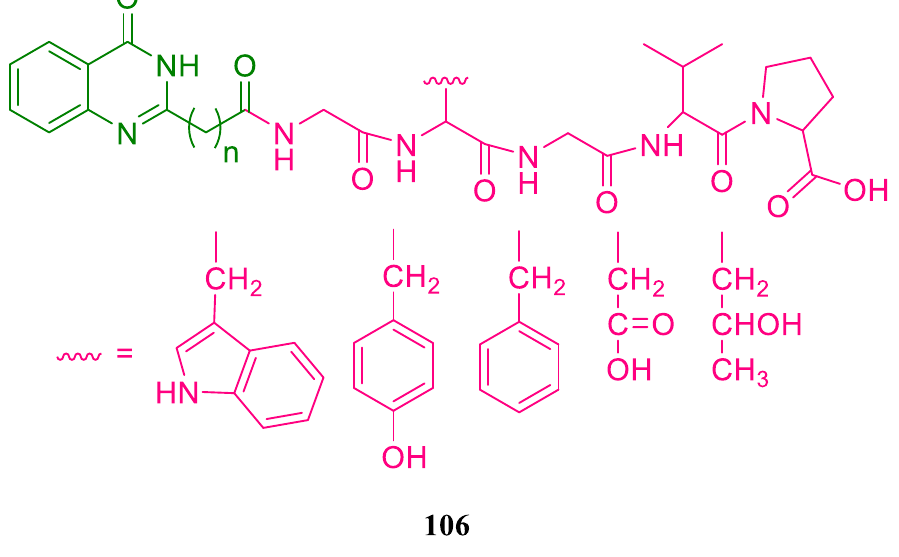
Figure 86. Peptides conjugated to quinazolinones.